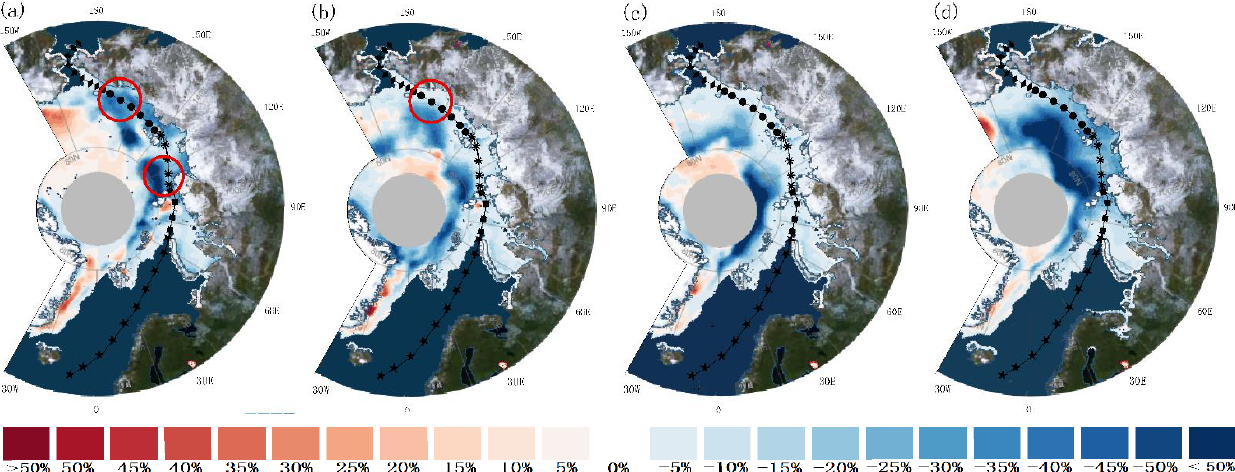
Figure 10. The anomalous distribution of sea ice concentration from July to October 2020 ( a – d ). (The outliers are based on the period from 2011 to 2020, the red circles represent the special areas.).